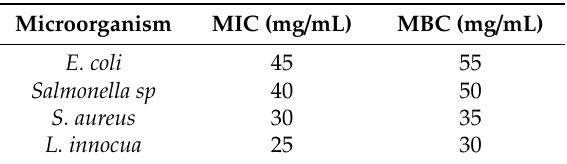
Table 6. Minimum inhibitory concentration (MIC) and minimum bactericidal concentration (MBC) of extracts from EOP. All assays were carried out in